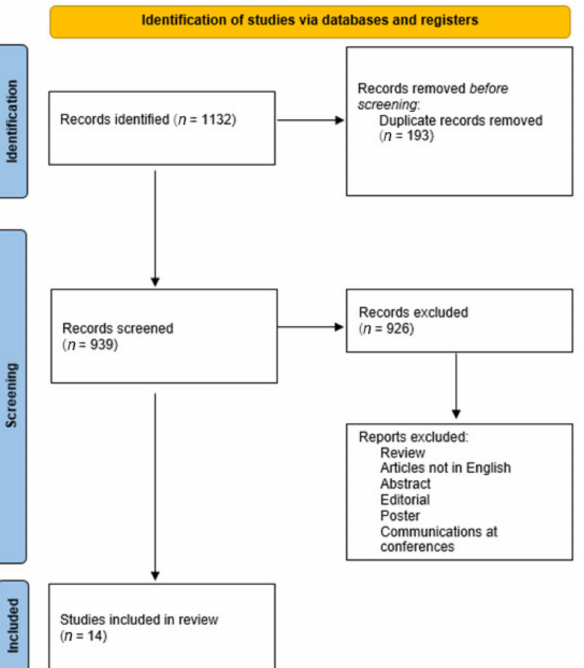
Figure 3. Flow diagram illustrating studies included in and excluded from this systematic